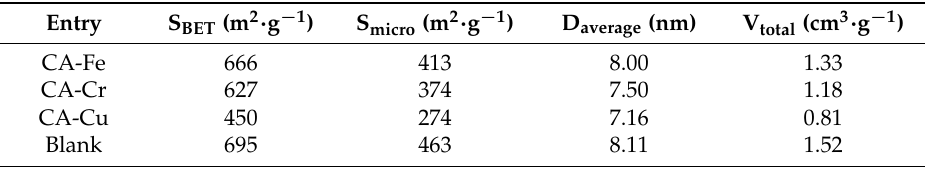
Table 3. Pore structure of the